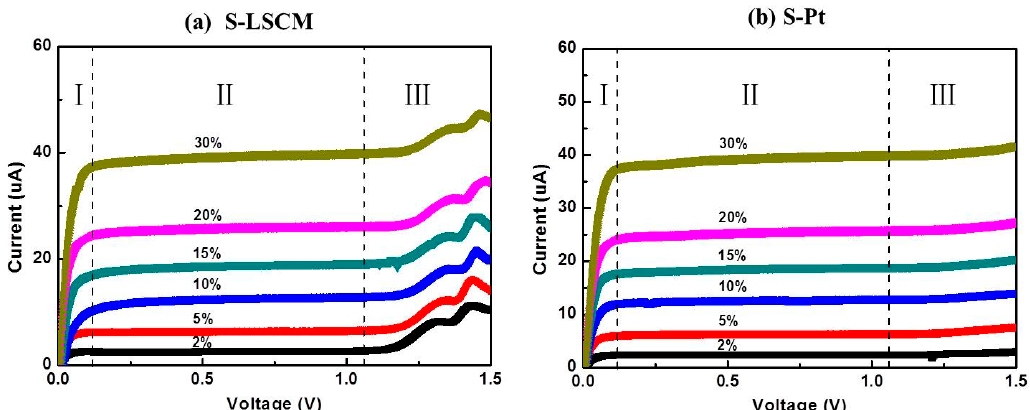
Figure 5. Current-voltage characteristic curves of ( a ) S-LSCM and ( b ) S-Pt, measured at 580 °C, with the oxygen concentration in the range of 2–30%.